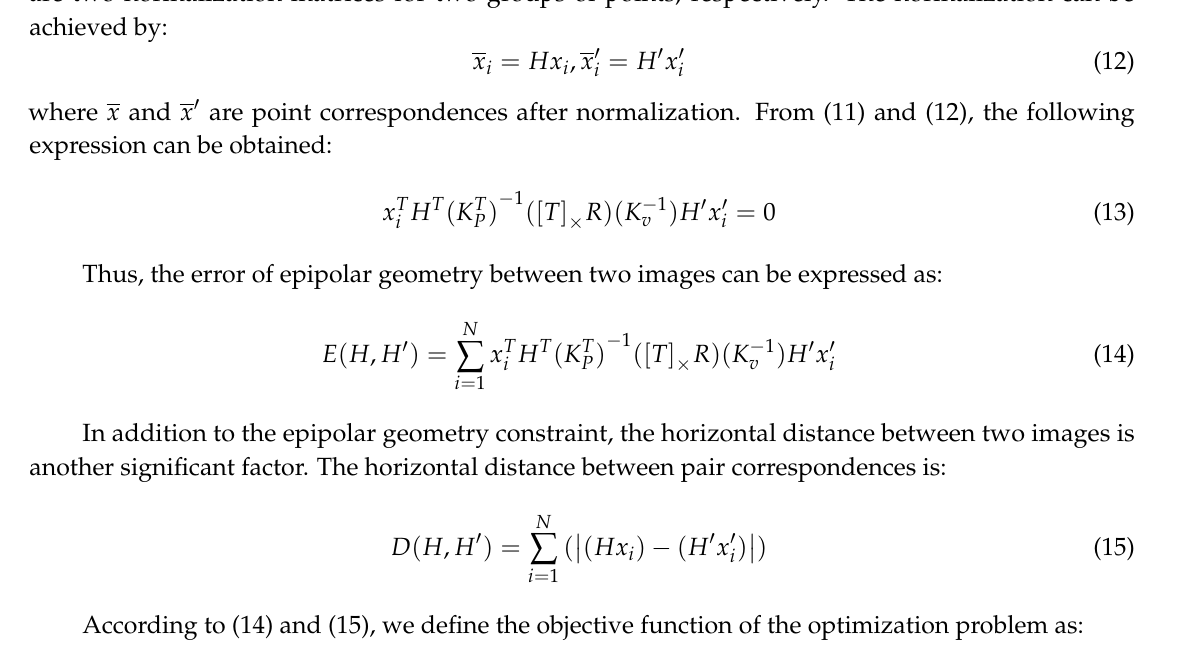
Figure 6. The epipolar geometry of the virtual perspective image and conventional image. π (cid:48) p and π (cid:48) v are the rectified images. It is obvious that the rectified images are column aligned.